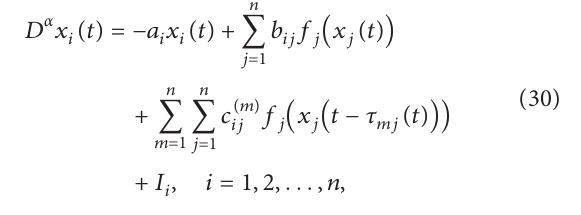
Figure 4: The change processes of error e initial